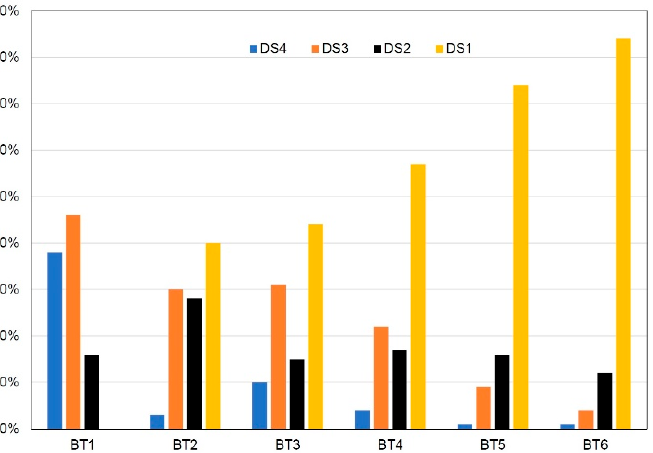
Figure 4. The distribution of damage states for various building types for 1193 buildings surveyed after the 2010 Kraljevo, Serbia earthquake (based on [34]).